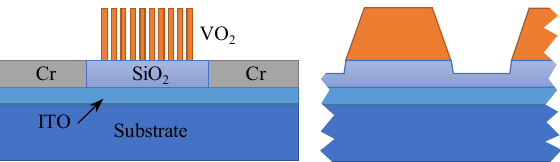
Fig. 1. Design of the resistive heating element underneath and waveguide structure on top. Both parts are electrically isolated by a thin film of SiO 2 . The dimensions are not to